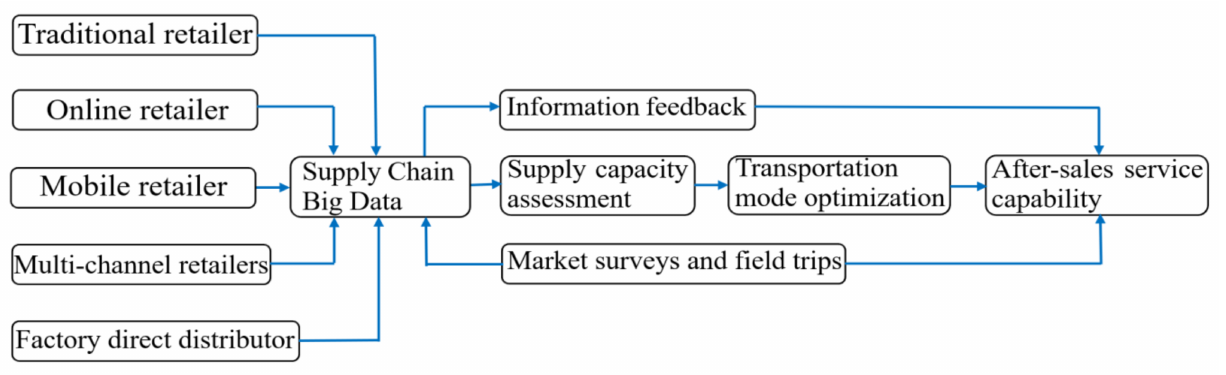
Figure 14. Schematic diagram of big data omnichannel assessment